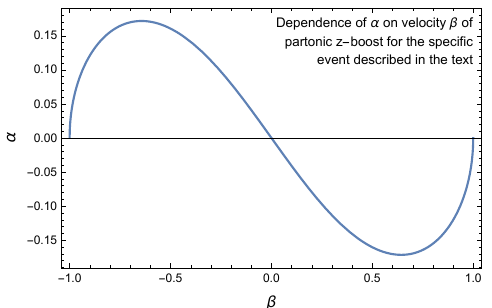
Figure 2 . Dependence of (cid:11) on the longitudinal velocity (cid:12) of the three-jet system for the exam- ple con(cid:12)guration described in the